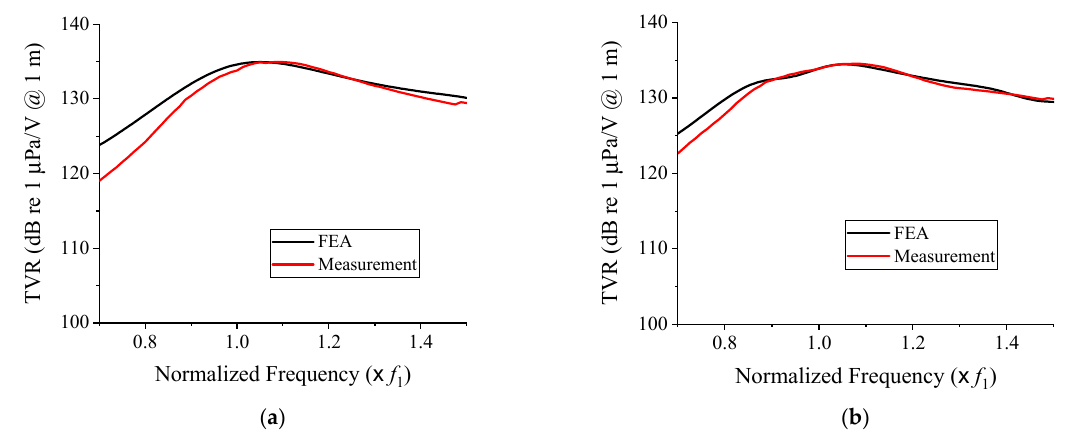
Figure 11. Comparison of the simulated and measured TVR spectra of the prototype cymbal arrays: ( a ) initial; ( b ) opti- mized models. Table 4. Quantitative comparison of the simulated and measured acoustic characteristics of the pro- totype cymbal arrays: ( a ) initial; ( b ) optimized models.